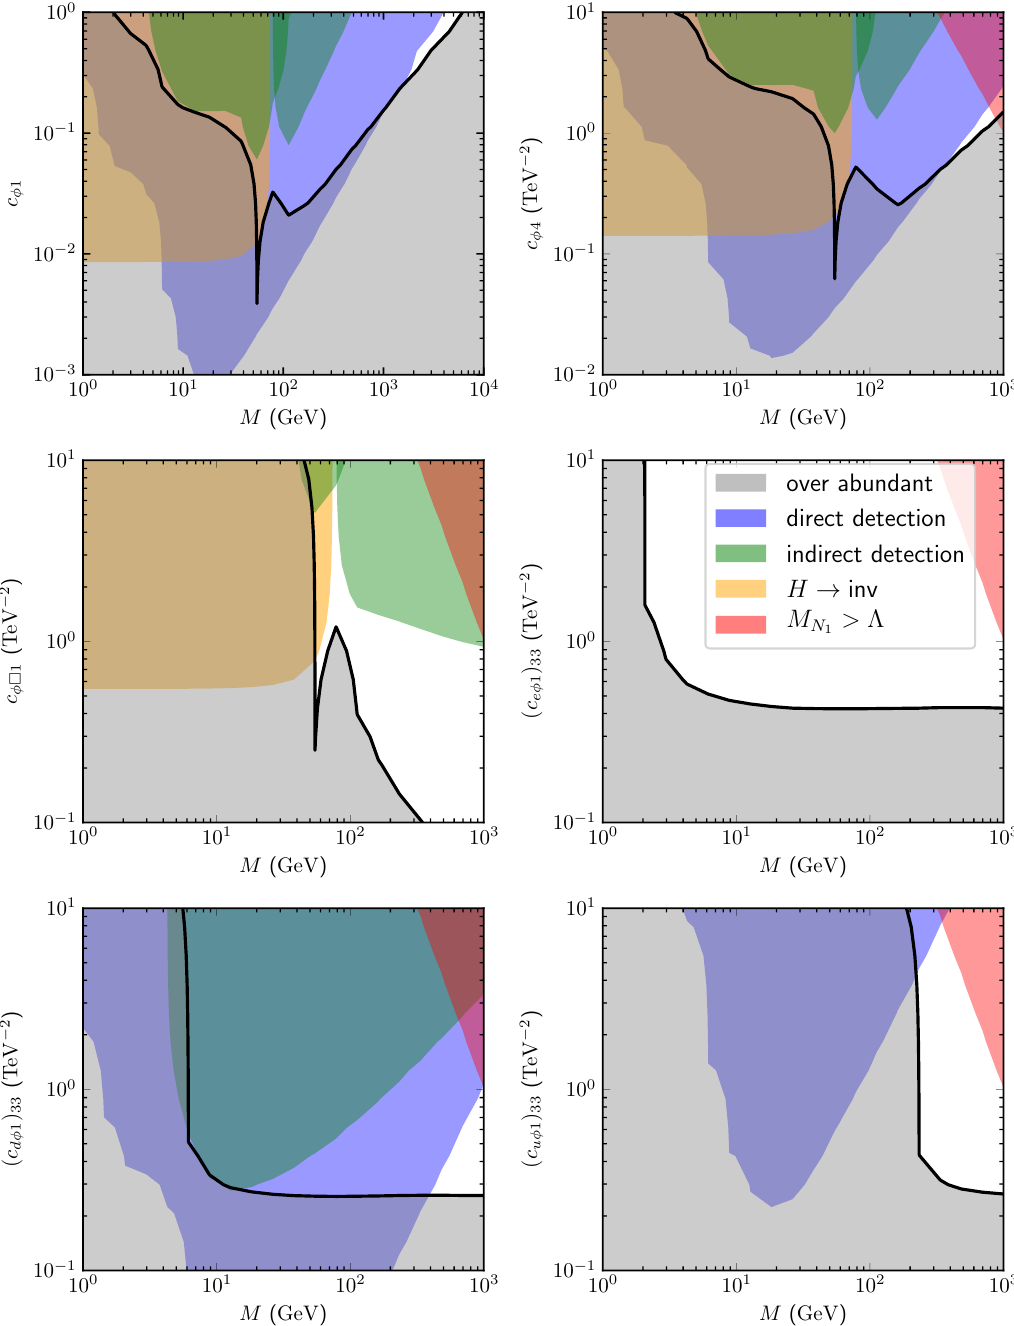
Figure 1 . Constraints on the coefficients of the operators coupling the DM particle to the Higgs boson and/or SM fermions, as a function of the DM particle mass. The points over the solid black line give the correct DM abundance. The gray region gives an overabundance of DM. The orange region is excluded by the bound on H → invisible from ATLAS and CMS. The blue region is excluded by the XENON1T and the DarkSide-50 experiments. The region excluded by the limit on the annihilation cross section set by Planck is shown in green. The EFT is no longer valid in the red